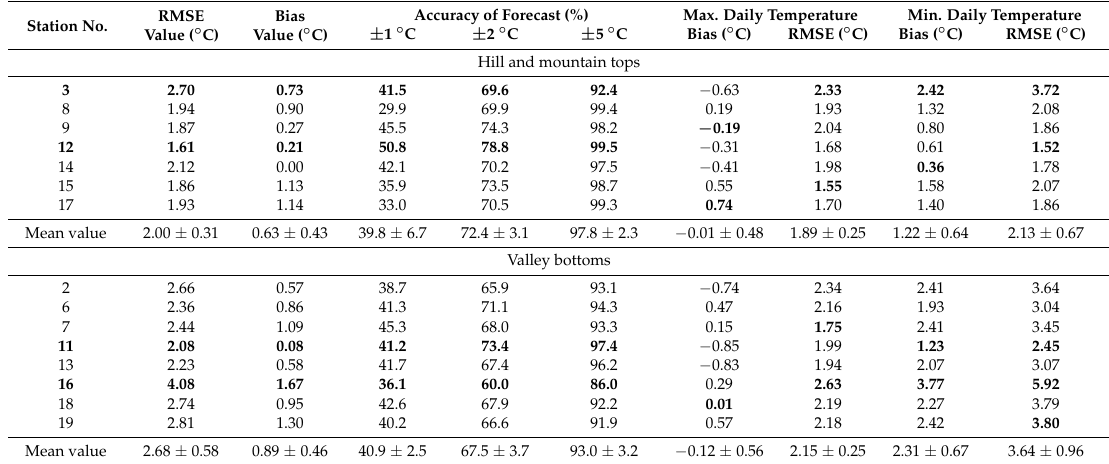
Data in bold signifies stations/points with highest and lowest RMSE value in each group.